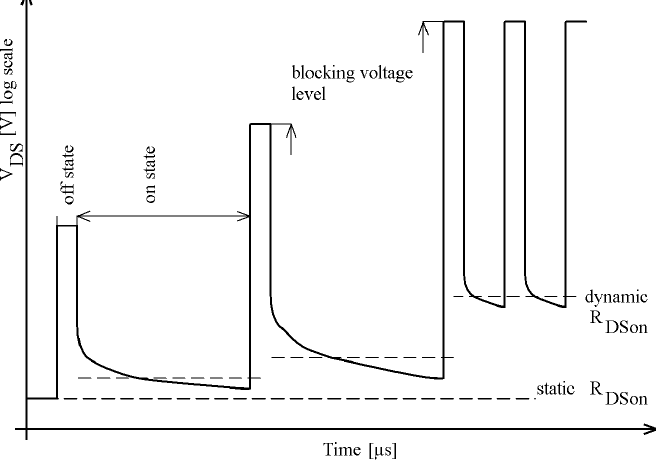
Figure 2. Current-collapse effect on on-state resistance.